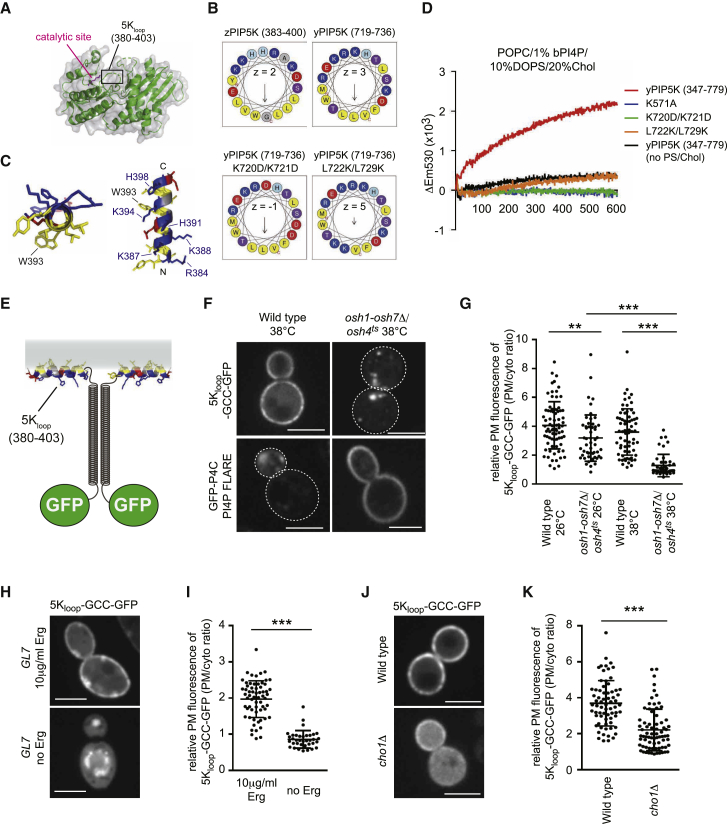
The PIP5K Specificity Loop Requires Osh Proteins, PS, and Sterols for PM Targeting(A) Crystal structure of zebrafish PIP5K (zPIP5K) (Hu et al., 2015). The specificity loop region (5Kloop: residues 380–403) was disordered in the crystal structure. The catalytic site (residue K236 in zPIP5K corresponding to K571 in yeast PIP5K) is shown in magenta.(B) The amphipathic properties of the specificity loop of zPIP5K and yeast PIP5K (yPIP5K). Helical wheel representations were drawn using HeliQuest. Hydrophobic residues are shown in yellow, arginine and lysine in dark blue, histidine in light blue, serine in purple, and glutamate and aspartate in red. Substitutions disrupting charge and the amphipathic property of the specificity loop of yPIP5K are shown in the bottom row (K720D/K721D and L722K/L729K, respectively). Z indicates net charge and arrows in helical wheels correspond to the hydrophobic moment.(C) The amphipathic character of the specificity loop of zPIP5K (5Kloop) using PEP-FOLD 3 and PyMOL.(D) Real-time PIP5K assays using 200 nM wild-type or mutant forms of the yeast PIP5K domain (yPIP5K). K571A is a kinase-dead form of yPIP5K. Data represent mean values (n ≥ 3; SEM < 0.61 × 103).(E) Design of the 5Kloop-GCC-GFP FLARE.(F) Localization of 5Kloop-GCC-GFP and GFP-P4C (PI4P FLARE) in wild-type and osh1-7Δ/osh4ts cells cultured at 38°C for 2 h.(G) 5Kloop-GCC-GFP PM signal in wild-type and osh1-7Δ/osh4ts cells. Data represent mean ± SD (n ≥ 46 cells).(H) Localization of 5Kloop-GCC-GFP in the sterol auxotroph GL7 strain cultured with or without 10 μg/ml ergosterol (Erg).(I) 5Kloop-GCC-GFP PM signal in GL7 cells. Data represent mean ± SD (n ≥ 36 cells).(J) Localization of 5Kloop-GCC-GFP in wild-type and cho1Δ mutant cells supplemented with 1 mM ethanolamine.(K) 5Kloop-GCC-GFP PM signal in wild-type and cho1Δ cells. Data represent mean ± SD (n ≥ 69 cells). Scale bars, 4 μm.∗∗p < 0.01, ∗∗∗p < 0.001. See also Figure S6.